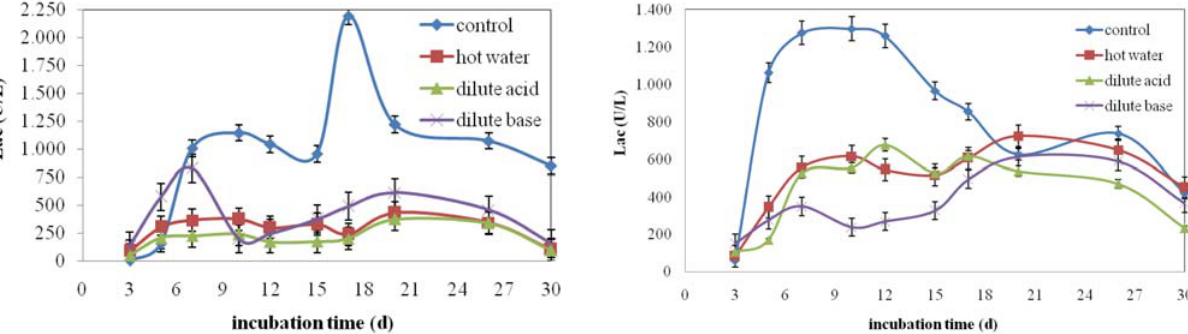
Figure 3. Variations of Lac activities depending on peach (left side) and cherry (right side) cultures. The values are the mean ± SD for experiments of three separate